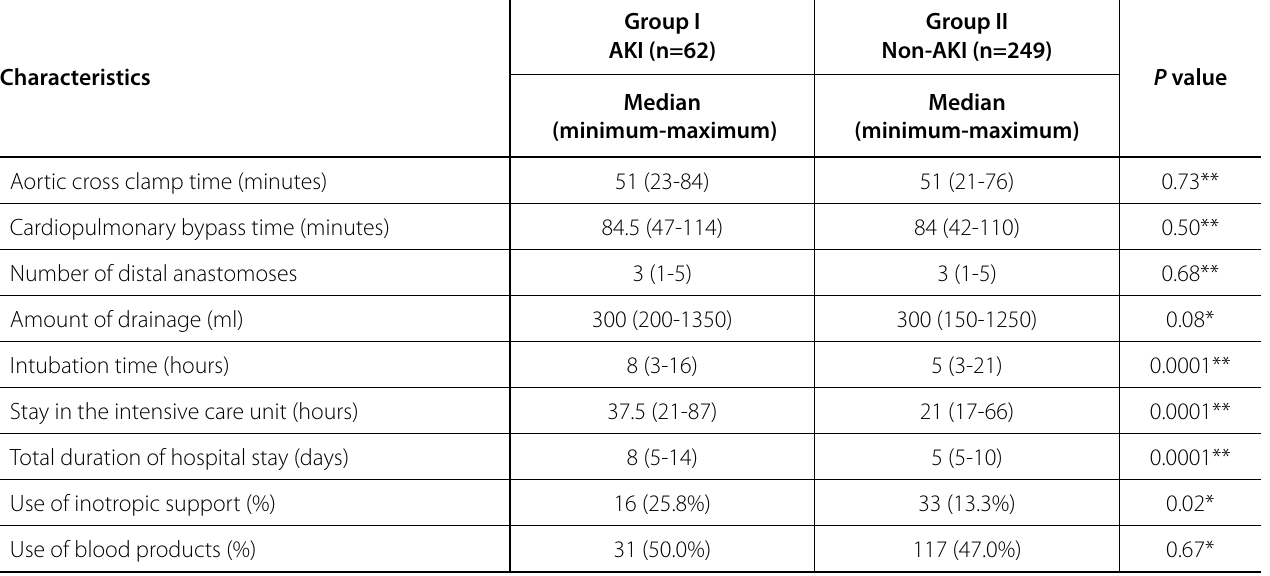
Table 4. Intraoperative and postoperative data of the